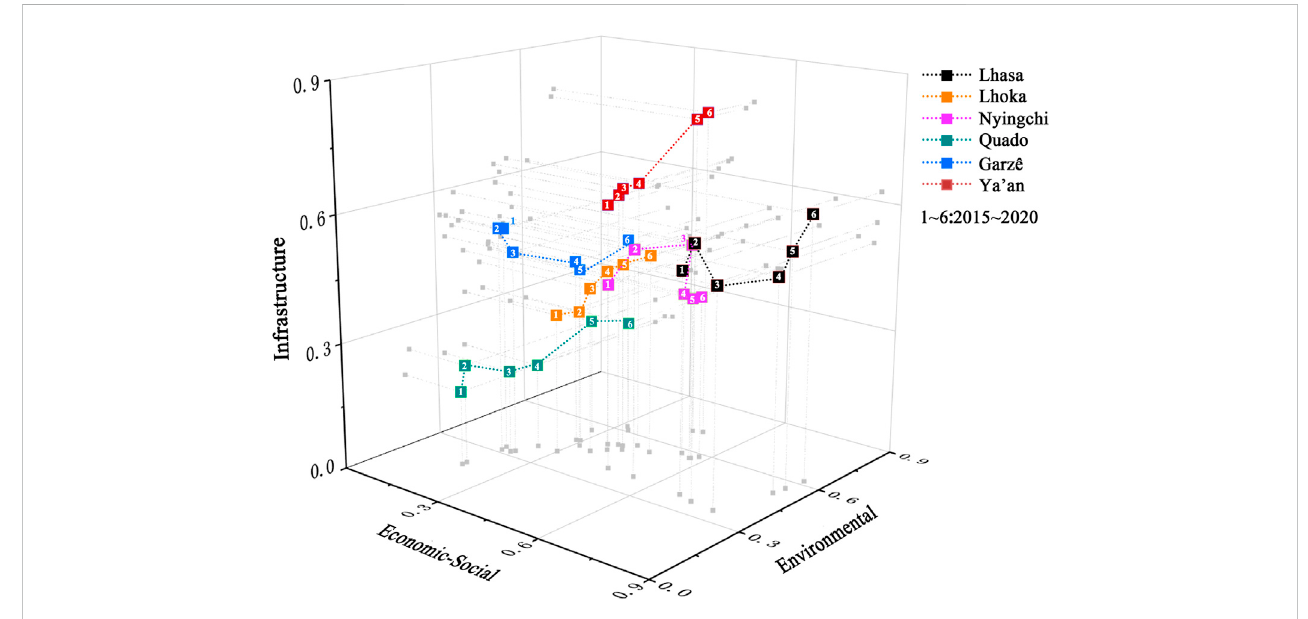
FIGURE 9 Three-dimensional evaluation model of urban